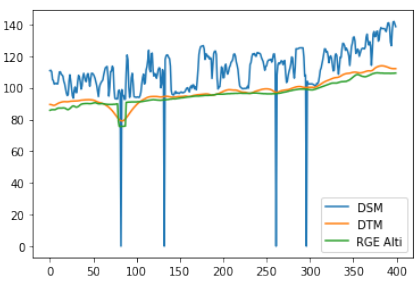
Figure 15. 1D profile of an area in Paris. Blue: DSM, Green: Ground truth (RGE Alti) and Orange: Bulldozer